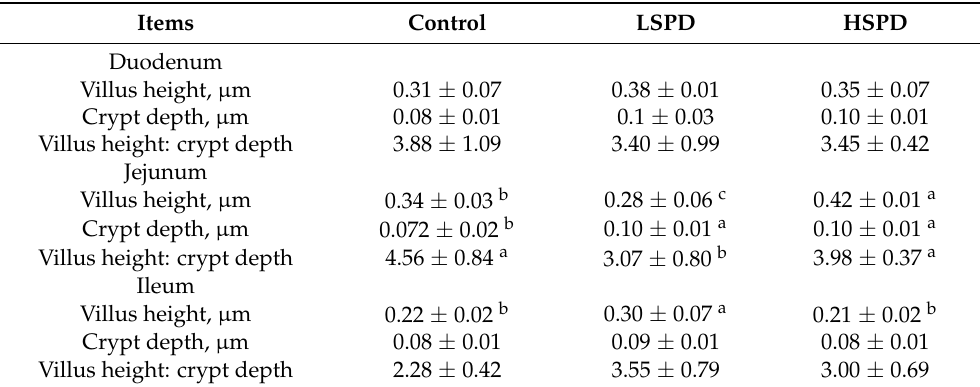
Figure 2. Histological evaluation of small intestine tissues ( × 100) of the mice after adding spermidine to their drinking water. The scale bar is 200 mm. Table 1. Intestinal villus heights, crypt depths, and chorionic gland ratios of the mice treated with